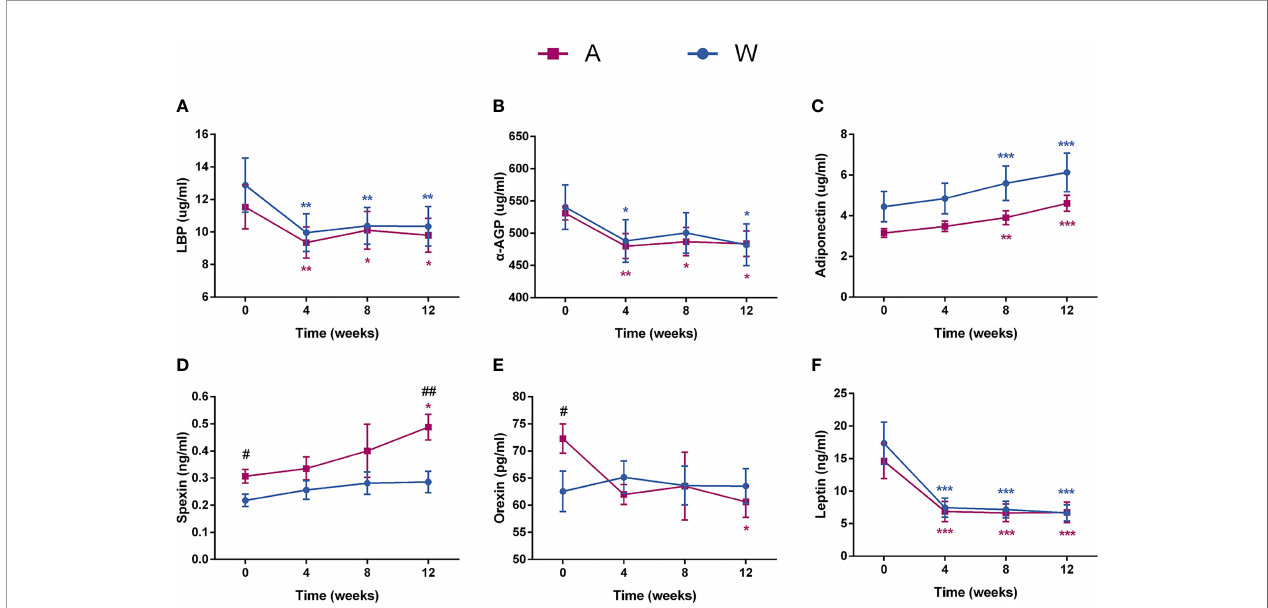
FIGURE 3 | The state of chronic low-grade in fl ammation and the secretion of brain – gut peptides were altered in patients with PCOS after the intervention. Serum (A) LBP, (B) a -AGP, (C) adiponectin, (D) spexin, (E) orexin, and (F) leptin levels were tested by ELISA. Date expressed as mean ± SEM. * p < 0.05, ** p < 0.01, and *** p < 0.001 for comparison with the week 0 value for the same group, red for A group and blue for W group. # p < 0.05 and ## p < 0.01 for comparison of A group with W group value at the same time point. LBP, lipopolysaccharide -binding protein; a -AGP, a -1-acid